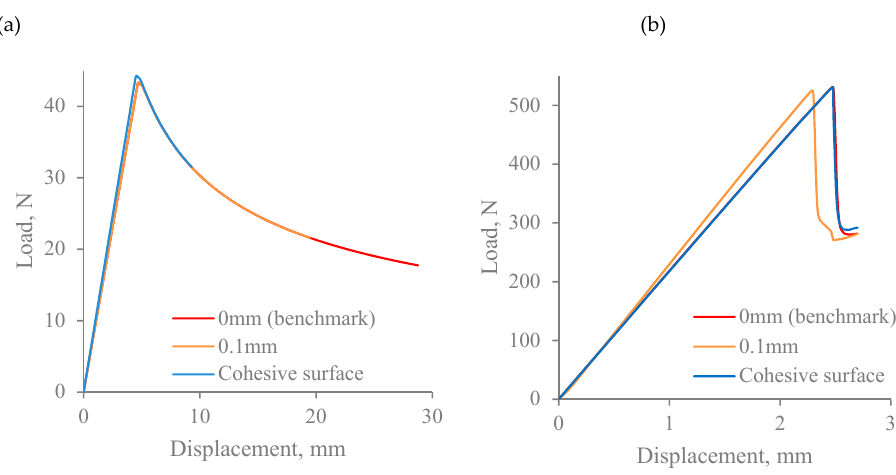
Figure 16. Load-displacement curves at different interface thicknesses and types of the interface layer: ( a ) Mode I simulation; ( b ) Mode II simulation.